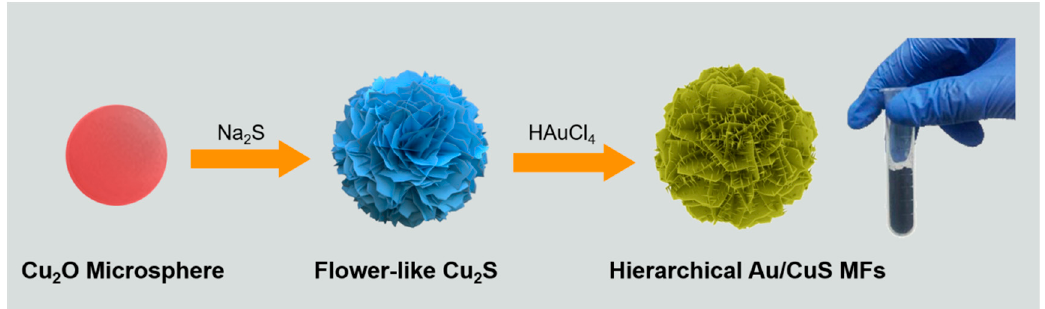
Figure 1. Schematic representation of the three-step solvent procedure for mass-production of 3D hierarchical Au/CuS MFs.